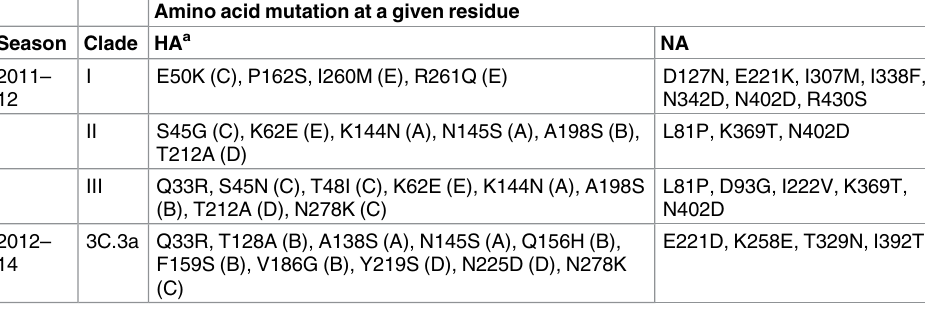
Table 2. Amino acid mutations associated with the Korean H3N2